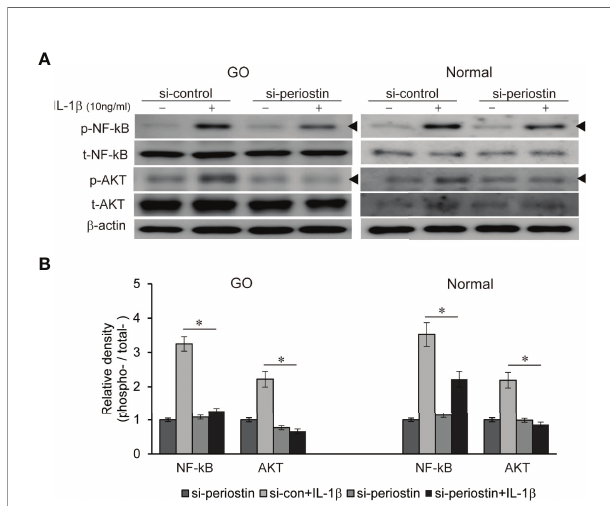
FIGURE 6 | Effect of silencing periostin on production of IL-1 b -induced signalling molecule in GO and normal fi broblast. Orbital fi broblasts from GO patients (n=3) and normal patients (n=3) were treated with 10 ng/ml IL-1 b before cells were transfected with control siRNA or periostin-targeting siRNA. Knock down of periostin attenuated IL-1 b -induced increase of phosphorylated NF-kB and AKT protein in both GO and normal orbital fi broblasts. (A) Representative bands from western blot analyses were shown (A) , and (B) the results are presented as the mean density ratio ± SD, normalized to the level of b -actin in the same sample. ( *p < 0.05 vs. IL-1 b -stimulated